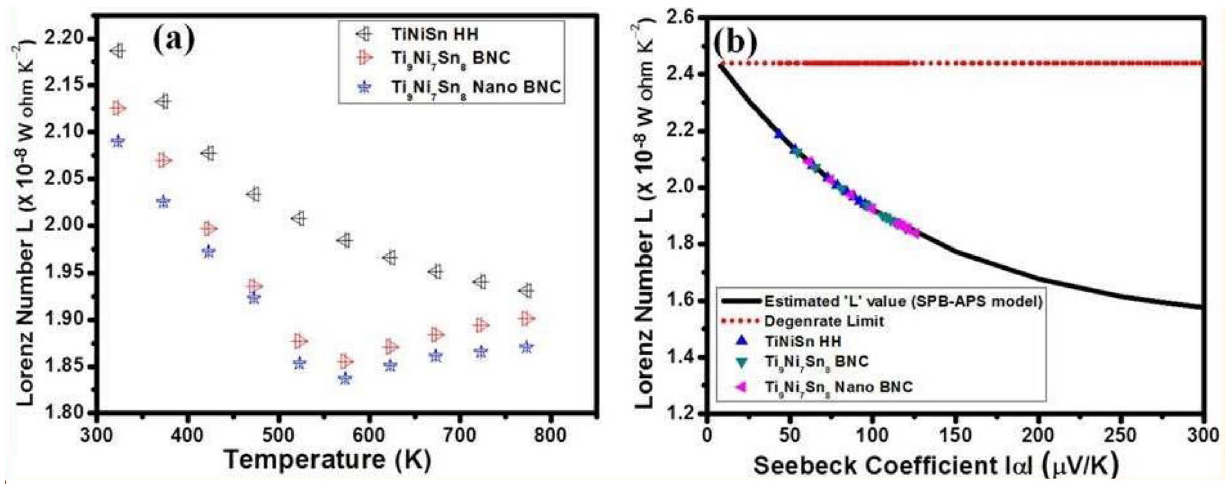
Fig. 5 a Temperature-dependent Lorenz number (L) of Ti¬9Ni Nano-BNC and TiNiSn (HH) and Ti 9 Ni 7 Sn 8 (BNC) for comparison; b Relation between Lorenz number (L) and Seebeck coefficient, α (T)